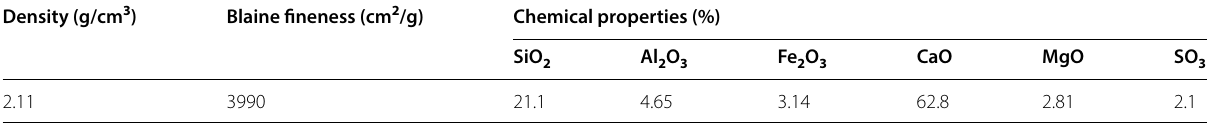
Table 1 Physical properties of FA.